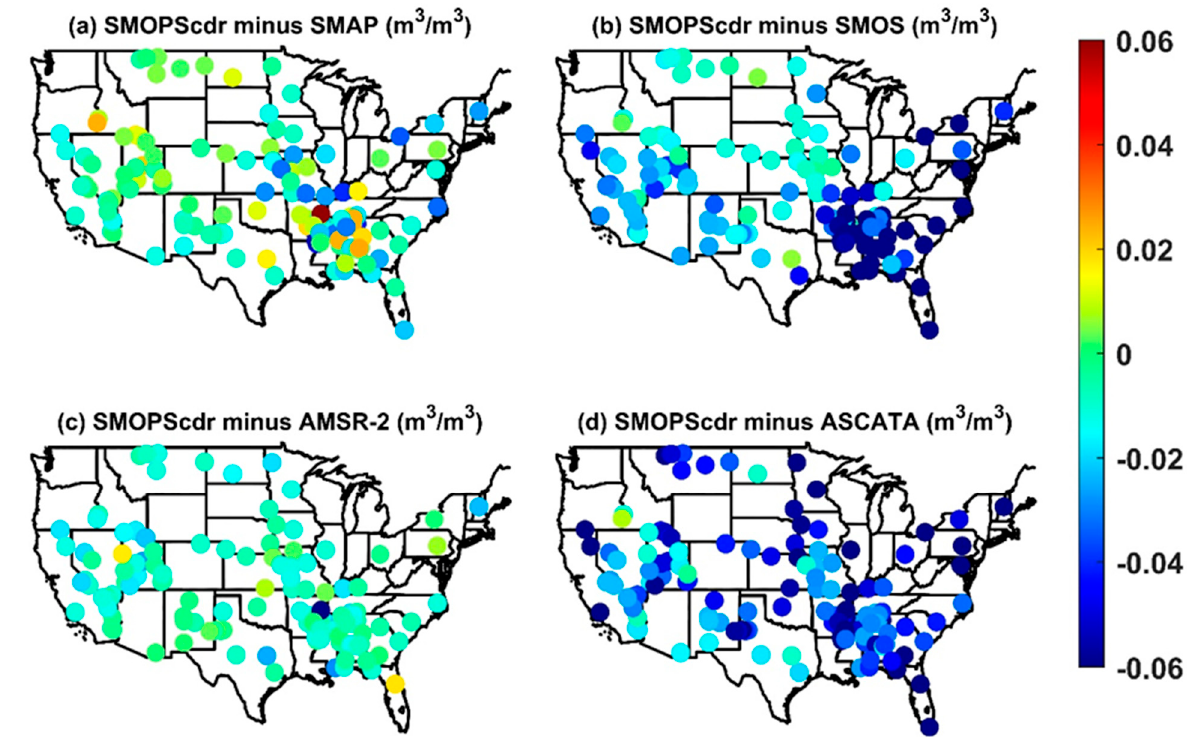
Figure 3. Differences in SCAN observations-based ubRMSE during 1 April 2015–30 August 2021 time period: ( a ) SMOPScdr minus SMAP, ( b ) SMOPScdr minus SMOS, ( c ) SMOPScdr minus AMSR-2, ( d ) SMOPScdr minus ASCATA. Patterns for ASCATA and ASCATB are very similar.